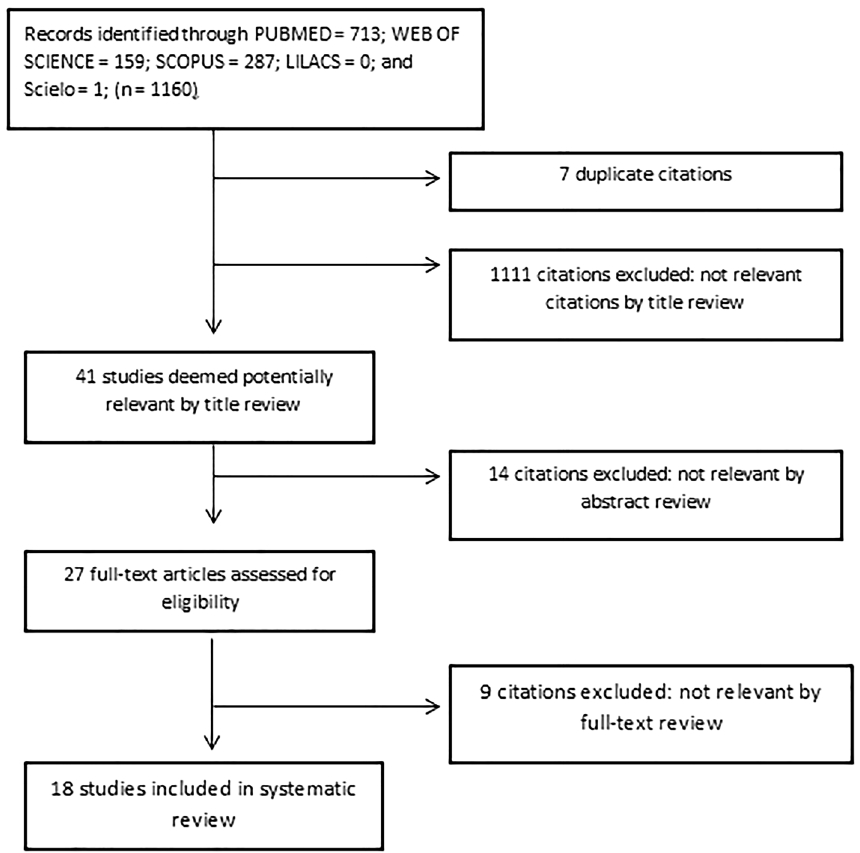
Figure 2. Flowchart of article selection process in accordance with PRISMA